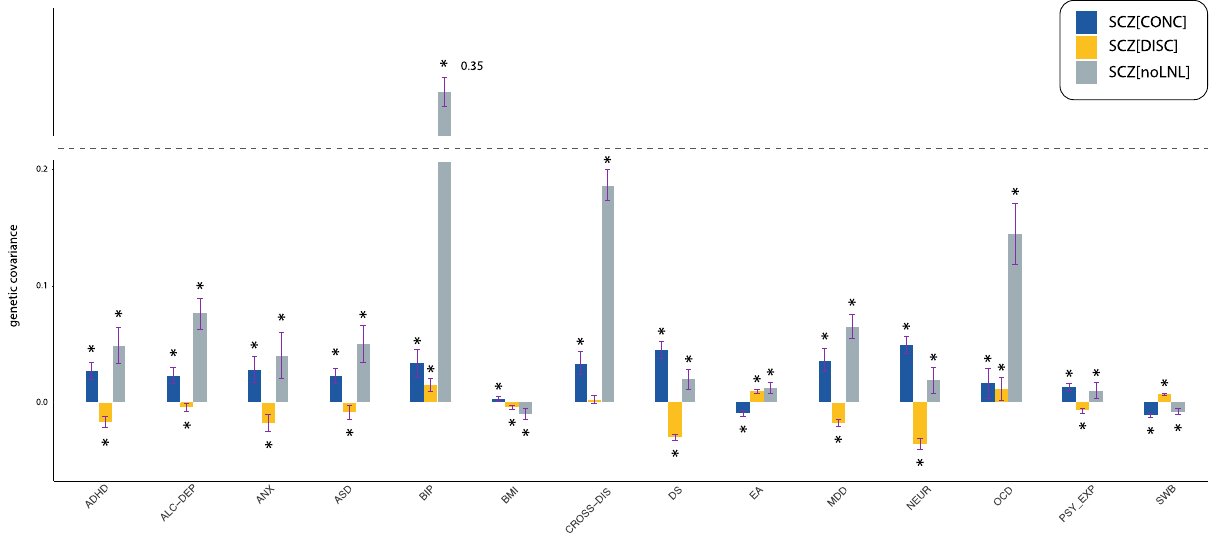
Fig. 4 Annotation-strati fi ed genetic covariance between schizophrenia and related traits. We calculated covariances with GNOVA within SNP subsets from SCZ[noLNL], SCZ[CONC], and SCZ[DISC] annotations. P -values were calculated for the genetic covariance based on two-sided Wald tests. Error bars represent 95% con fi dence intervals based on standard errors (covariance estimation + / − 1.96*SE). FDR-corrected signi fi cant associations ( p FDR < 0.05) are marked with an asterisk. Traits and disorders are abbreviated as follows: major depression (MDD), attention and de fi cit hyperactivity disorder (ADHD), autism spectrum disorder (ASD), anxiety disorder (ANX), bipolar disorder (BIP), obsessive-compulsive disorder (OCD), alcohol dependence disorder (ALC-DEP), cross-disorder phenotype (CROSS-DIS), neuroticism (NEUR), depressive symptoms (DS), subjective well-being (SWB), psychotic experiences in the general population (PSY-EXP), educational attainment (EA), and body mass index (BMI). For further details of the phenotypes see Supplementary Data 6 and Supplementary Methods